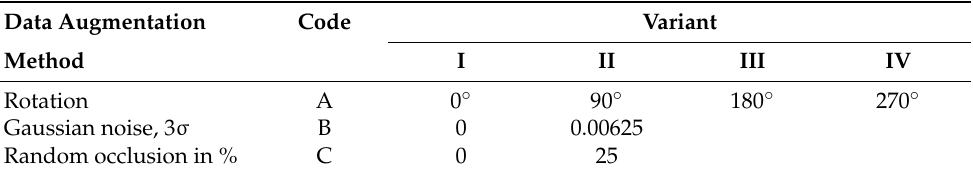
Table 3. Investigation matrix of the data augmentation methods. For the enlargement of the input data of the KidneyResNet, the influence of the data augmentation methods rotation, induction of Gaussian noise, and random occlusion was